Question: Sum up the contents of this chart in one sentence.
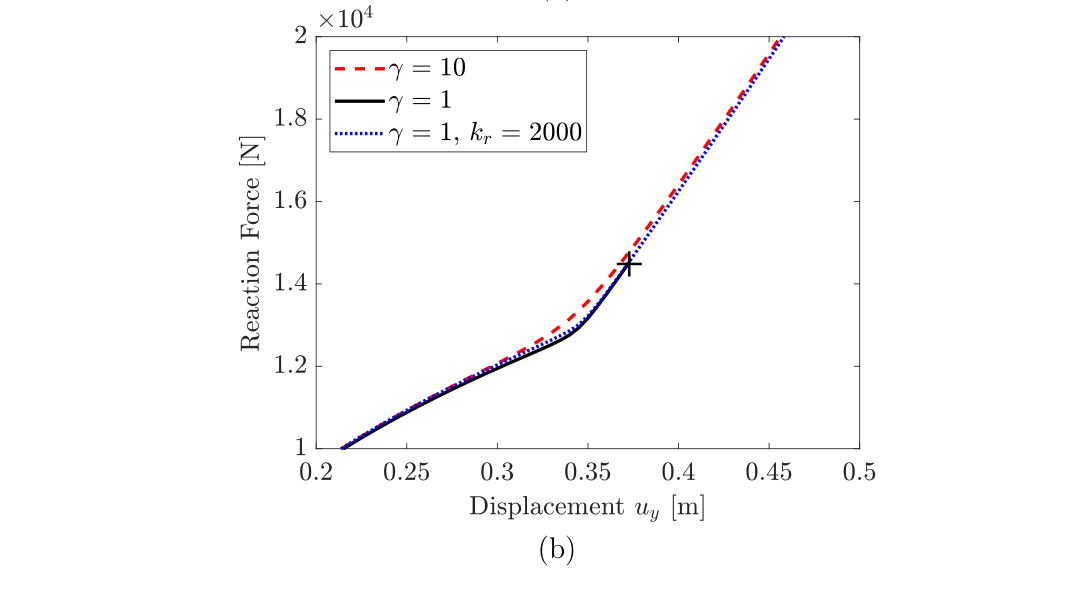
Answer: A rectangular cell loaded by a prescribed displacement, without pneumatic actuation. (a) Mesh and deformed configuration for γ = 10 (left), for γ = 1 (center), where only the last converged configuration is shown, with contact penetration and distorted third medium (see the inset), and for γ = 1 with the use of additional regularizing terms (right). (b) Comparison of force-displacement diagrams for different values of γ and regularization (only vicinity of contact initiation at uy = 0.3m shown).